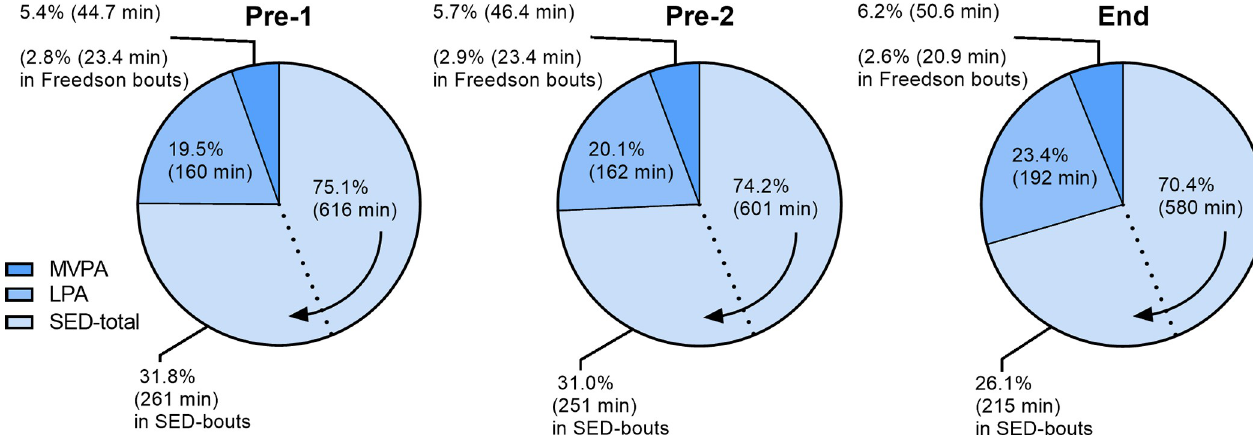
Fig 1. Results from the three test occasions Pre-1, Pre-2 and End in the exercise group. The average amount of time per day as well as percent of wear-time illustrated for SED-total, SED-bouts, LPA, MVPA and Freedson-bouts. The arrow indicates that the area for the SED-total also includes the area for the SED-